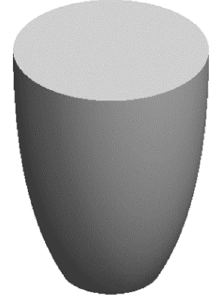
Figure 2. The appearance of a CPC.